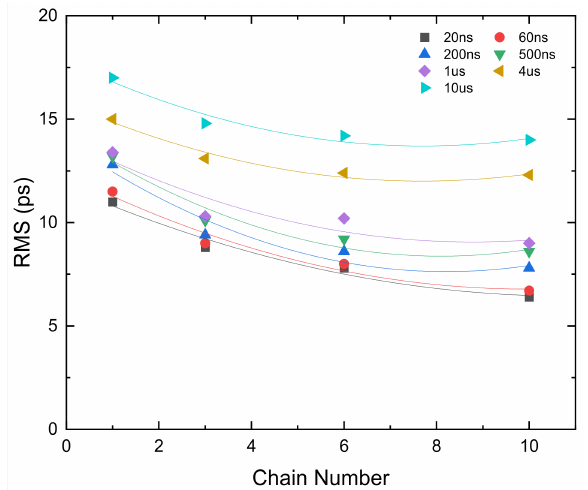
Figure 12. RMS precision of the TDC with different chain numbers for different time